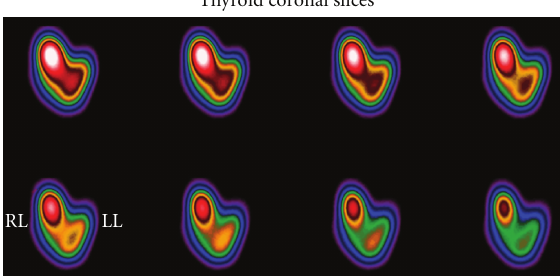
Figure 13: Sequential coronal slices of Thyroid SPECT study. Reconstruction made by FBP and Ramp-Butterworth prefiltering. Right lobe node delineation. Study is presented courtesy of